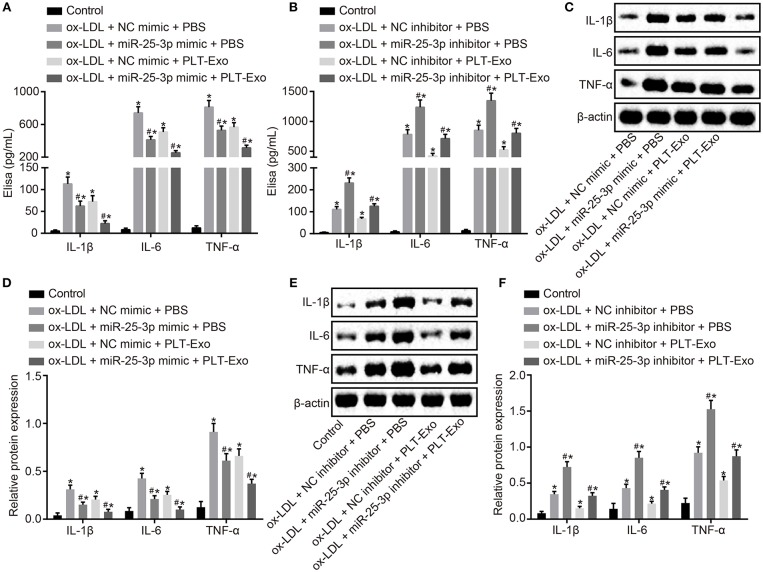
PLT-Exo containing miR-25-3p attenuates inflammatory reaction caused by ox-LDL. (A) Levels of IL-1β, IL-6, and TNF-α in the supernatant of CVECs treated with miR-25-3p mimic, PLT-Exo or co-transfection of miR-25-3p mimic and PLT-Exo, as measured by ELISA. (B) Levels of IL-1β, IL-6, and TNF-α in the supernatant of CVECs treated with PLT-Exo and miR-25-3p inhibitor, as detected by ELISA. (C,D) Protein bands and levels of IL-1β, IL-6, and TNF-α in CVECs treated with miR-25-3p mimic, PLT-Exo or co-transfection of miR-25-3p mimic and PLT-Exo, as measured by Western blot analysis. (E,F) Protein bands and levels of IL-1β, IL-6, and TNF-α in CVECs treated with PLT-Exo and miR-25-3p inhibitor, as determined by Western blot analysis. *p < 0.05 vs. the ox-LDL + NC mimic/inhibitor + PBS group (CVECs co-treated with ox-LDL + NC mimic/inhibitor + PBS); #p < 0.05 vs. the ox-LDL + miR-25-3p mimic/inhibitor + PBS group (CVECs co-treated with ox-LDL + miR-25-3p mimic/inhibitor + PBS) or the ox-LDL + NC mimic/inhibitor + PLT-Exo group (CVECs co-treated with ox-LDL + NC mimic/inhibitor + PLT-Exo). The measurement data are expressed as mean ± standard deviation and data among multiple groups were analyzed using one-way ANOVA. The experiment was conducted three times independently.